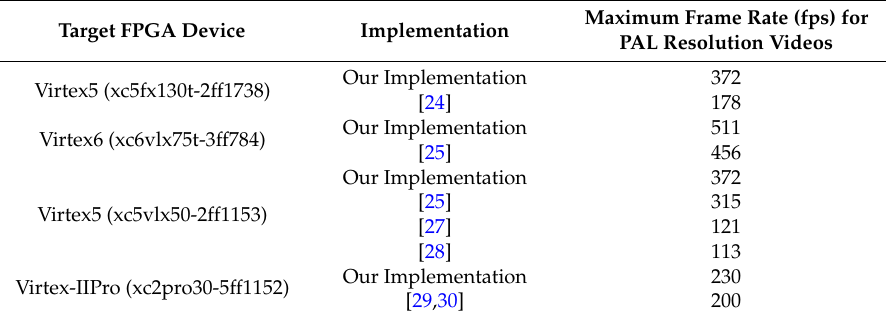
Table 3. Performance Comparison with Existing Motion Detection